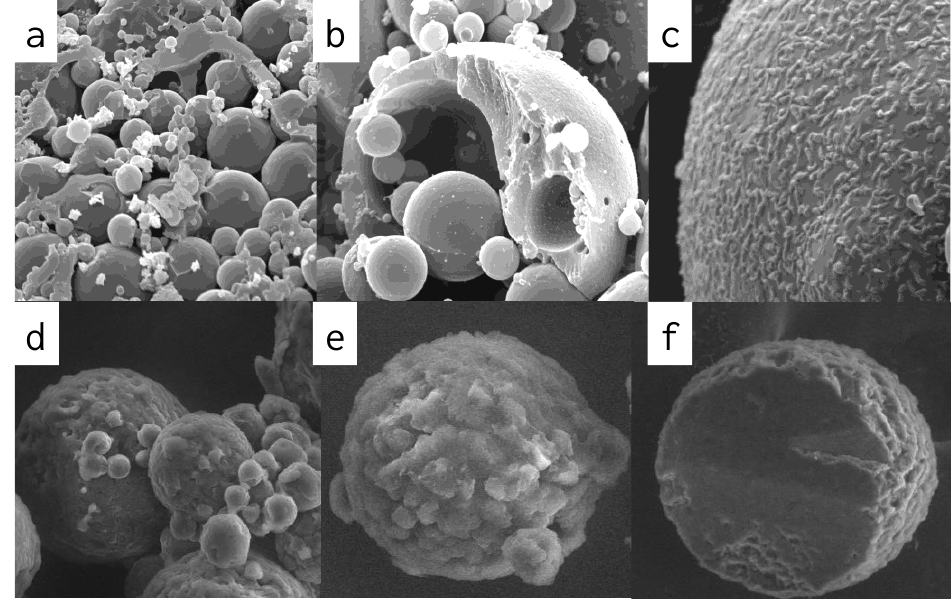
Figure 3. SEM photographs of polymeric microparticles, namely eudragit RS ( a , b ) and hydroxy- propylmethylcellulose ( c ), and lipid-based microparticles, namely tripalmitin:glyceryl monostarate 2:1 by weight ( d – f ). Bar represents 20 μm in panels ( a , b ), 10 μm in panel ( c , d ), and 40 μm in panel ( e , f ).